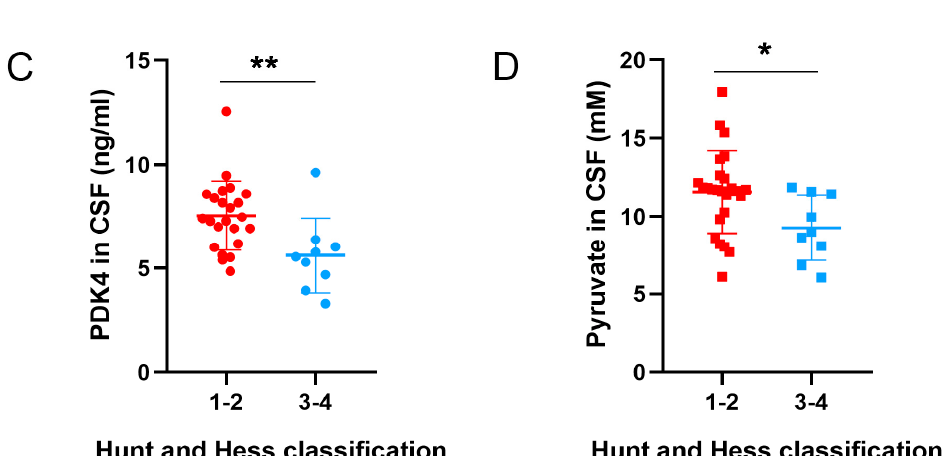
Figure 7. Scatter plots of the levels of PDK4 and pyruvate sorted by injury category. Unpaired two-tailed t -tests indicated that higher expression of PDK4 and pyruvate was significantly associated with mild neurological injury 1–3 days after SAH ( A – D ). Bars represent the means ± SD. * p < 0.05; ** p < 0.01 vs. the indicated groups ( n = 7 in the severe injury group (GCS score < 12), n = 25 in the mild injury group (GCS score 12–15), n = 9 in the Hunt–Hess 3–4 group and n = 23 in the Hunt–Hess 1–2 group).